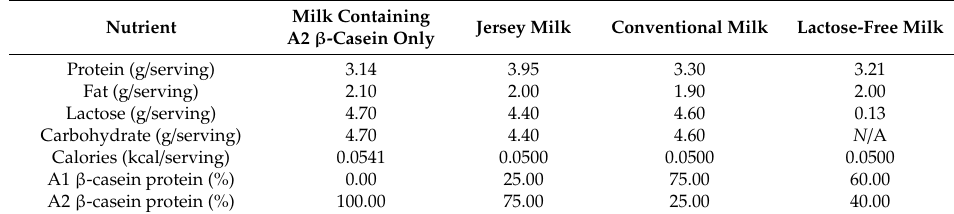
Table 2. Nutrient composition of the four milk